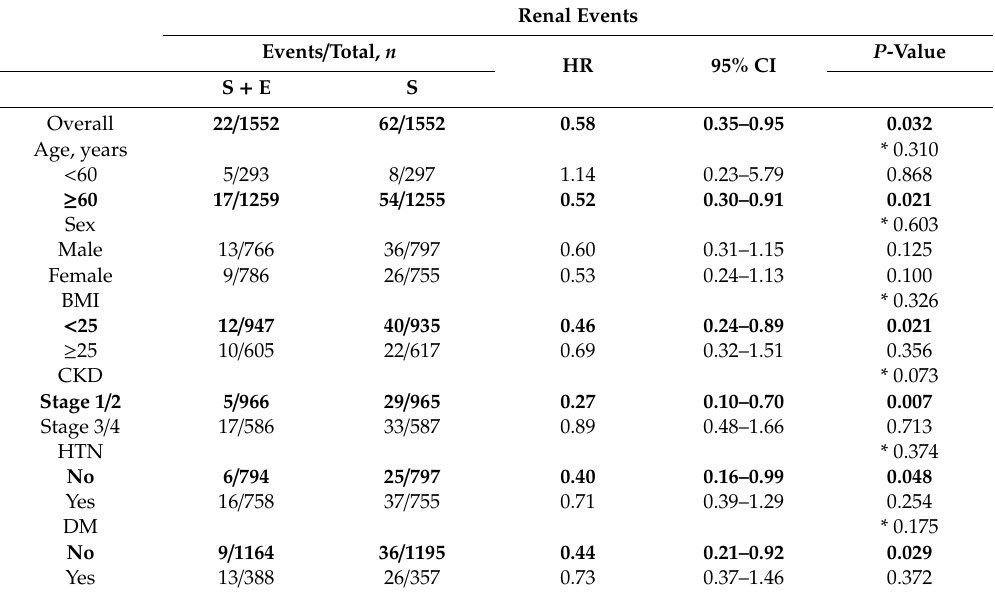
Figure 2. Kaplan–Meier analysis of cumulative incidence of renal events. P -value is from log-rank test. S, simvastatin; S + E, simvastatin + ezetimibe. Table 2. Adjusted hazard ratios (HR) for renal events in propensity-score-matched groups.